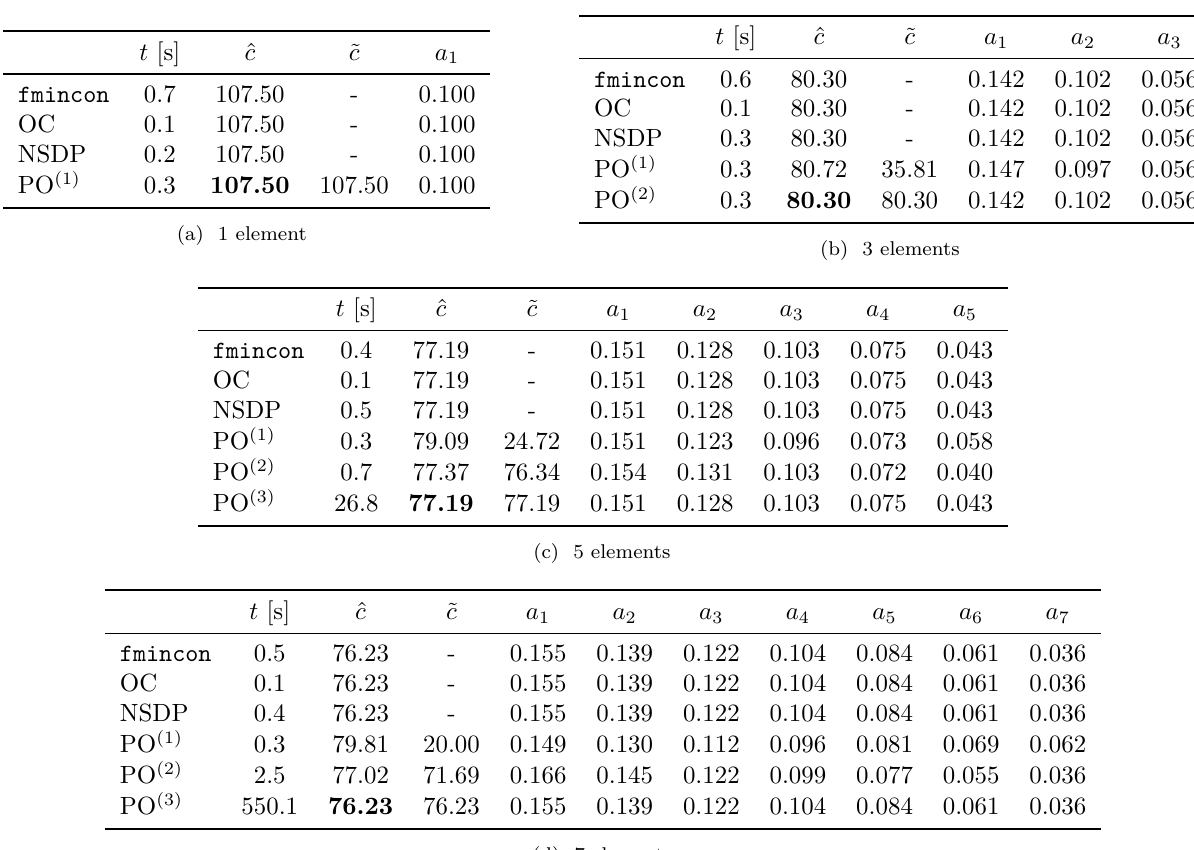
Table 1. Comparison of the four optimization approaches on the design of the cantilever beam problem. Bold text denotes the proven global optimum.